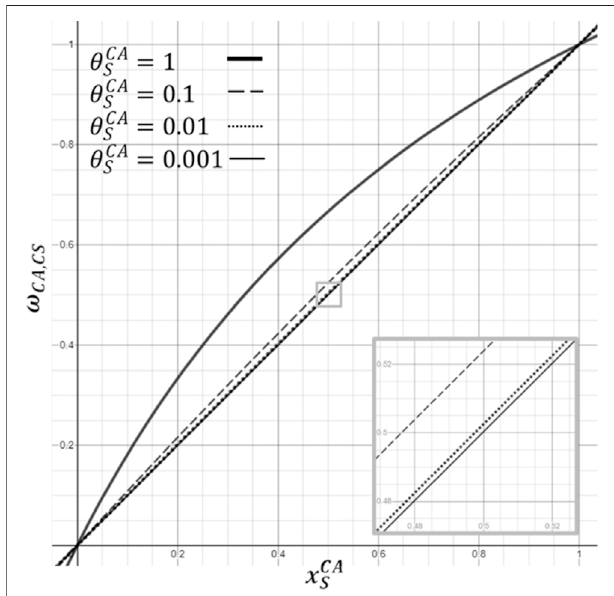
FIGURE 4 | Illustration of effect of the size of a weighting factor ( θ CA S ) of the sensitivity of a CA to a certain stimulus concentration ( x CA S ) on the overall cell activity ( ω CA , CS ) . Example of different values ranging from θ CA S (cid:2) 0 . 001 to θ CA (cid:2) 1. S